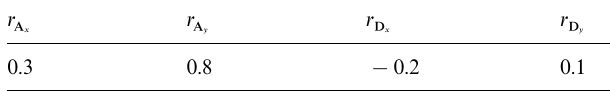
Table 1. Values of the correlation coefficients between the time ozone variation and the terms of the horizontal advection along the x and y directions (A (cid:120) and A (cid:121) , respectively) and of horizontal- velocity divergence (D